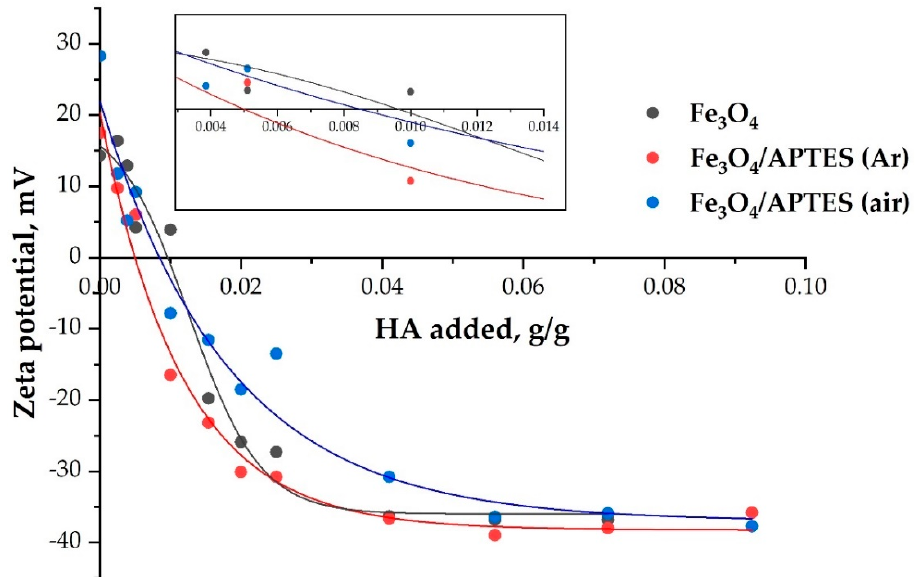
Figure 6. The effect of HA addition on the charge state of magnetite nanoparticles dispersions (pH ∼ 5 and KCl = 0.01 M). Lines are drawn as guides for the eye ( p -value < 0.05).